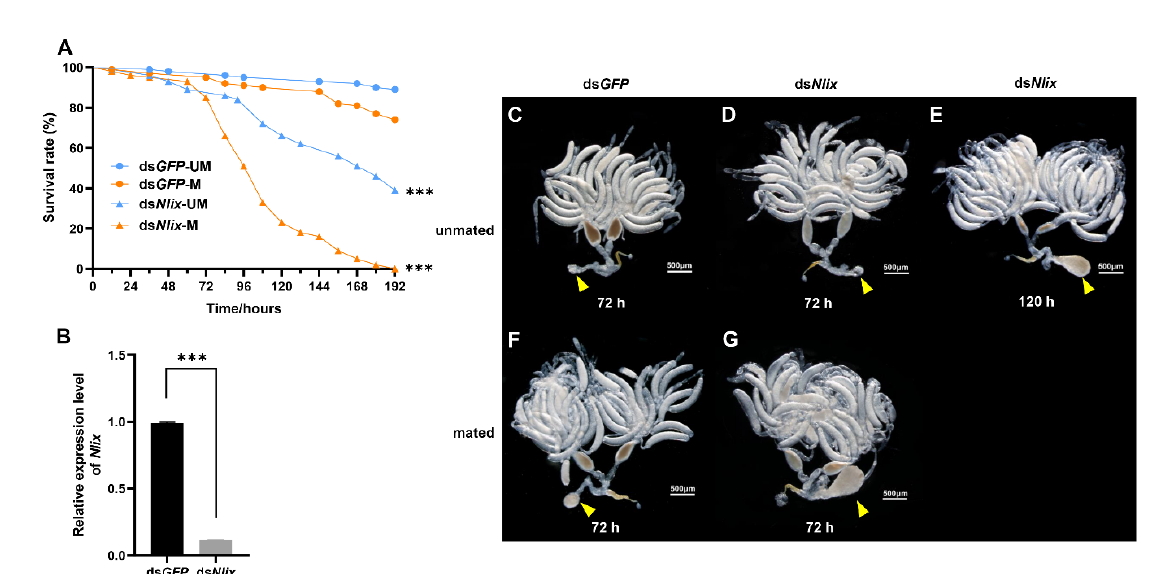
Figure 1. ( A ) Survival rate of BPHs at 192 h after RNAi when the newly emerged females were injected with dsRNA. ds GFP was used as control in each group, n = 100. Statistical analysis was performed by log-rank (Mantel–Cox) test. Survival rates were significantly decreased for both ds Nlix -UM compared to ds GFP -UM and ds Nlix -M compared to ds GFP -M. *** p < 0.001. M: samples mated with males; UM: unmated samples; ( B ) Transcript levels of Nlix after RNAi treatment in the newly emerged females. The RNAi efficiency of Nlix was evaluated by collecting 10 insects at 72 h after injection. Means ± SEM from three experiments. *** p < 0.001 (Student’s t -test); ( C – E ) Ovarian development phenotypes of unmated females after 72 h and 120 h of different treatments; ( F , G ) Ovarian development phenotypes of mated females after 72 h of different treatments. Yellow triangle: copulatory bursa.